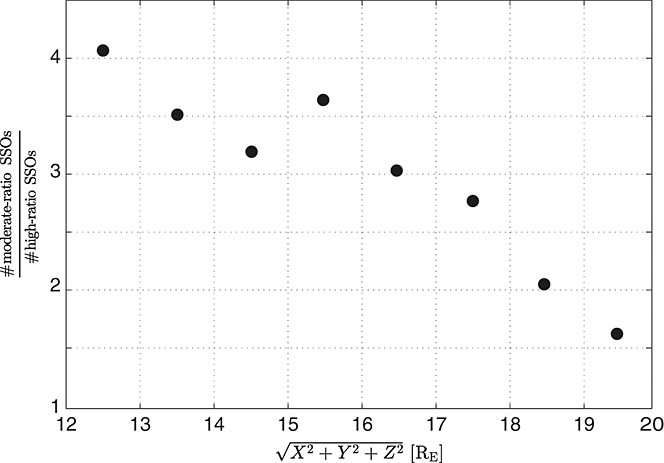
Binned ratio of the numbers of “moderate-ratio” SSOs (0.8 < Tratio < 1.2; 0.8 < nratio < 1.2) to the number of “high-ratio” SSOs (Tratio ≥ 1.2; nratio ≤ 0.8) with a bin size of 1RE.